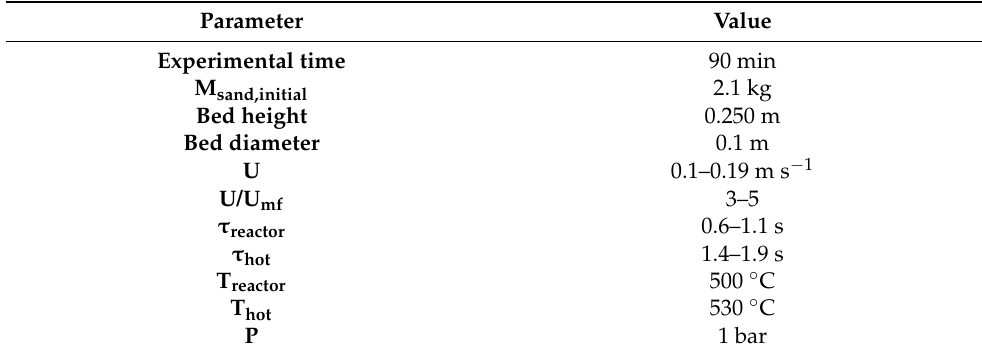
Table 1. Bubbling fluidized bed reactor (BFBR) operational parameters. Parameter